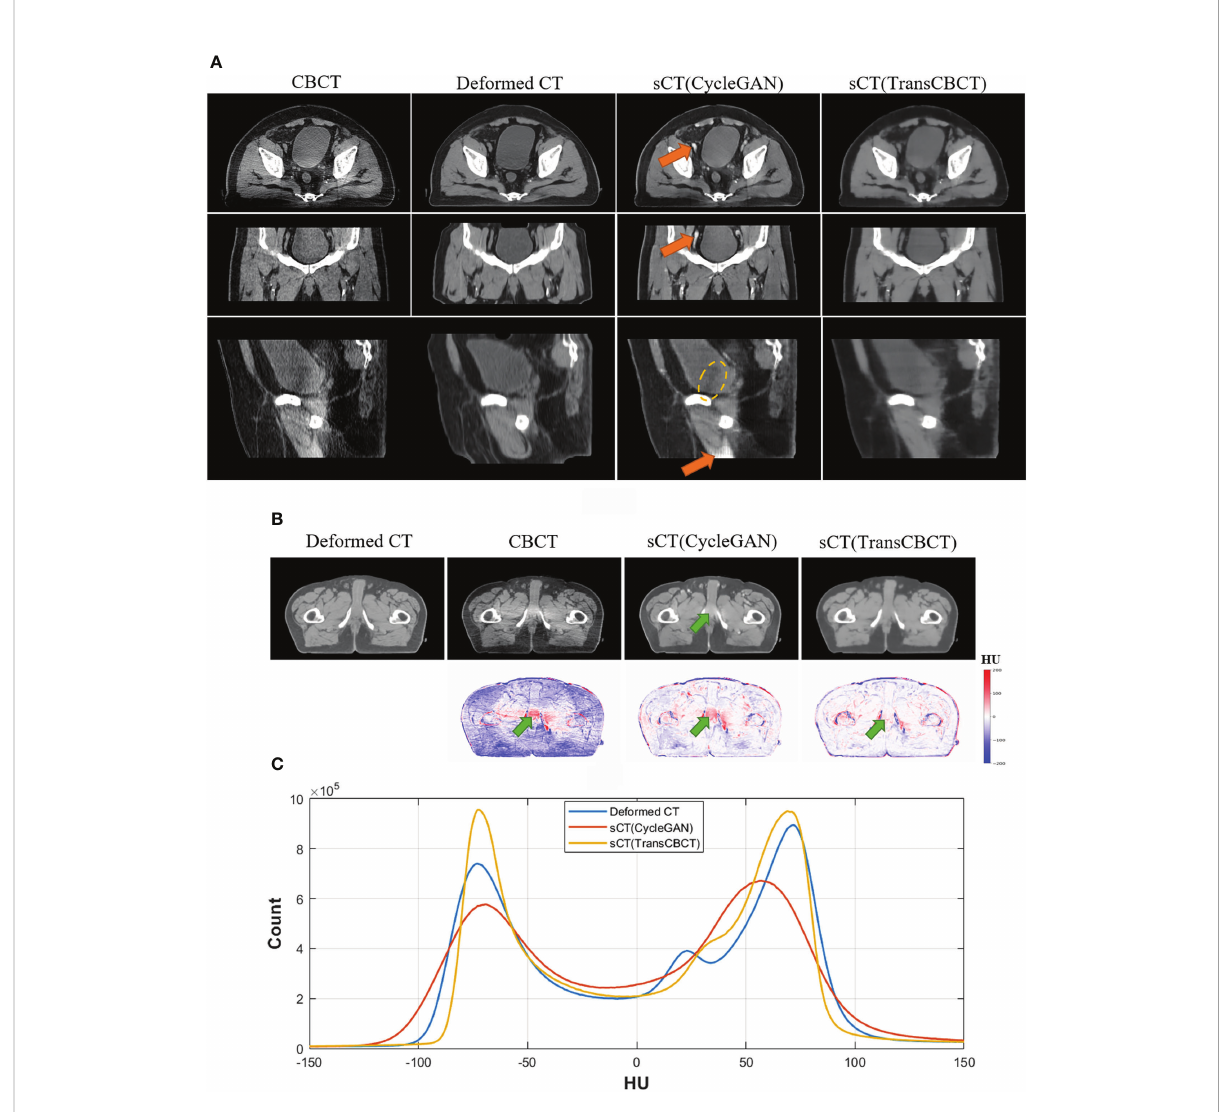
FIGURE 4 (A) Axial, sagittal, and coronal views of one patient. The orange arrows indicate the abnormal structure on sCT images. Yellow lines indicate the obvious beam hardening artifacts. Anatomical differences can be obtained, especially on the bladder sizes and locations, because of the time intervals between CT and CBCT scanning. The TransCBCT and CycleGAN maintained the same structure as CBCT with a clear organ edge. (B) Example of an axial slice of the deformed CT, CBCT, and sCT with the HU difference compared to the deformed CT image. The green arrows indicate the “ photon starving ” artifacts. (C) The HU histogram plot calculated on the entire test